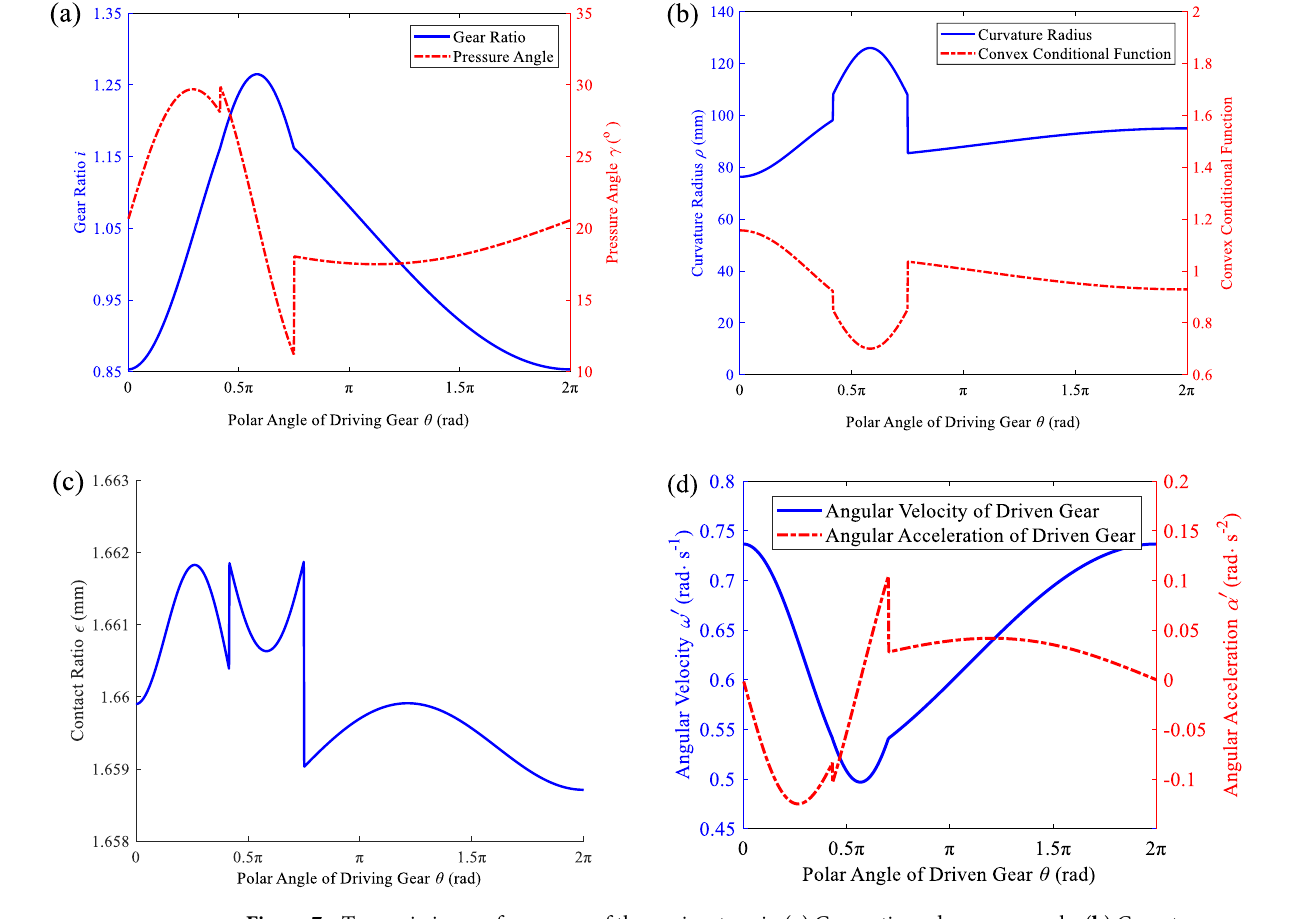
Figure 7. Transmission performances of the conjugate pair. ( a ) Gear ratio and pressure angle. ( b ) Curvature radius of the driving and driven gears. ( c ) Contact ratio. ( d ) Angular velocity and angular acceleration of the driven gear.